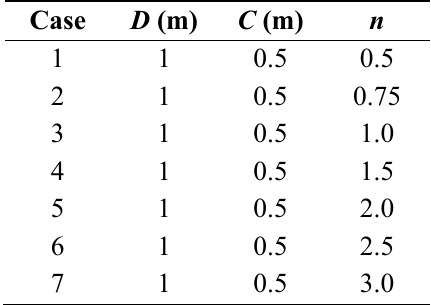
Table 1. Main structural parameters of the tested models.